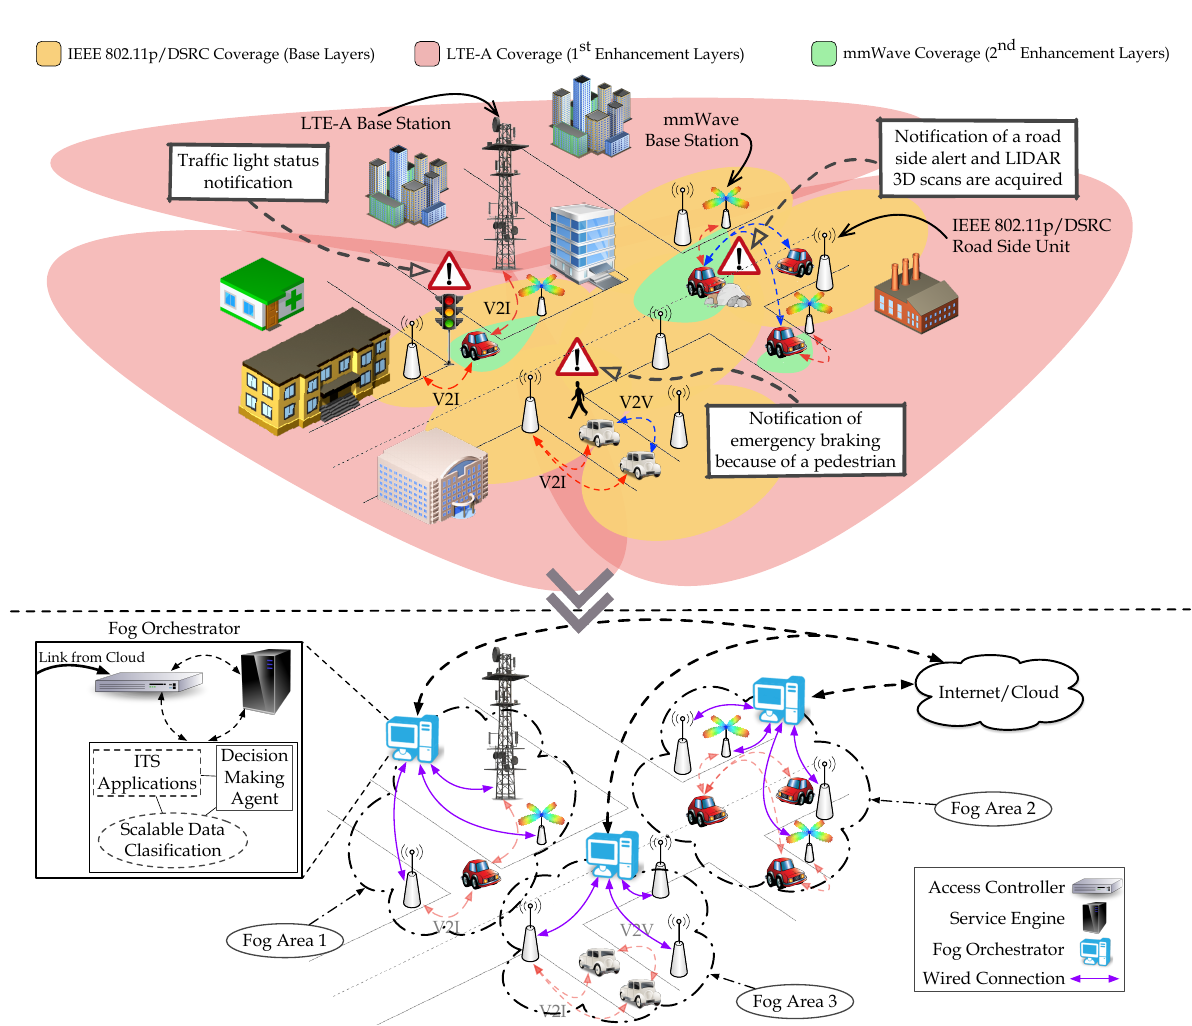
Figure 1. General overview of the considered system model. The proposed ITS design framework ensures analog- like performance degradation communications among CAVs by means of multi-layer V2X communications over an heterogeneous network